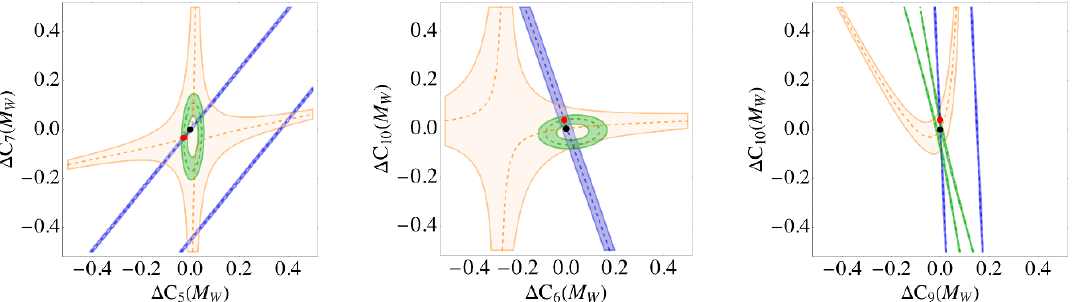
Figure 2. Overlaid individual constraints from radiative decay (blue), lifetime ratio (green), width di(cid:11)erence (orange) upon (cid:1) C 5 (cid:1) C 7 plane (left), (cid:1) C 6 (cid:1) C 10 plane (middle), (cid:1) C 9 (cid:1) C 10 plane (cid:0) (cid:0) (cid:0) (right). The SM point and best (cid:12)t point are shown as the black and red dots respectively. (cid:22) C e(cid:11) and result in the dominant constraint for such scenarios coming from radiative 7 (cid:13) decay. As the coe(cid:14)cient (cid:22) C e(cid:11) enters (3.31) both quadratically as well as linearly, 7 (cid:13)